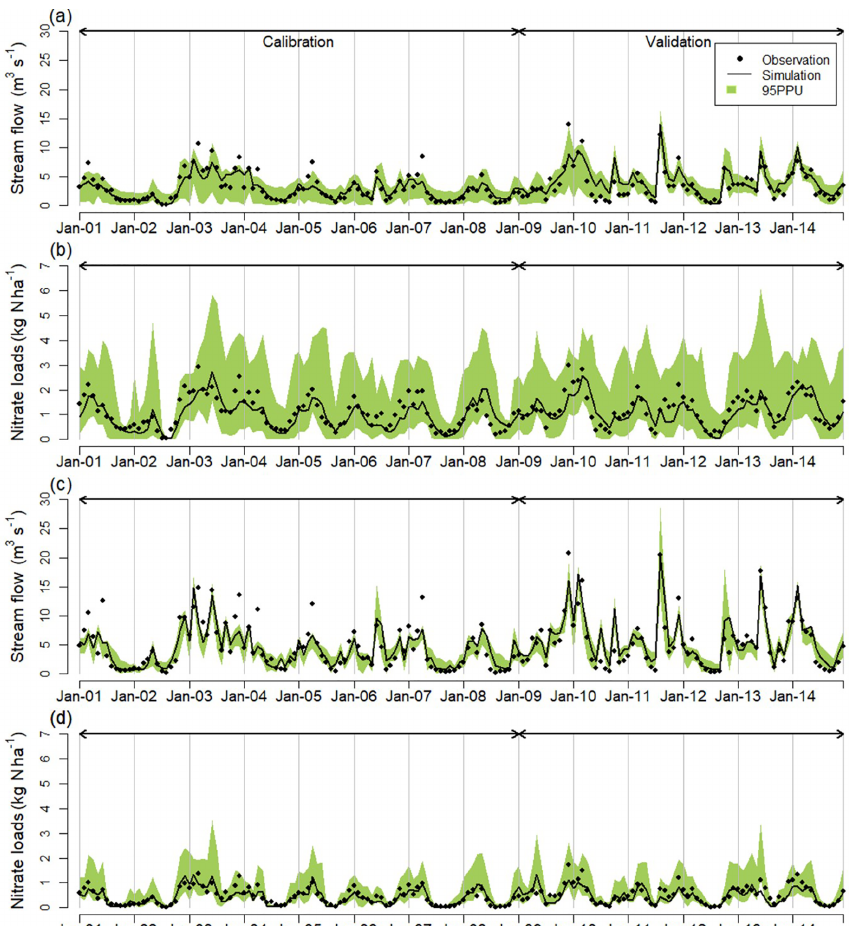
Figure 3. Simulated and observed monthly streamflow and nitrate loads for the (a, b) TCW and (c, d) GW during calibration and validation periods. Note: 95PPU stands for 95% prediction